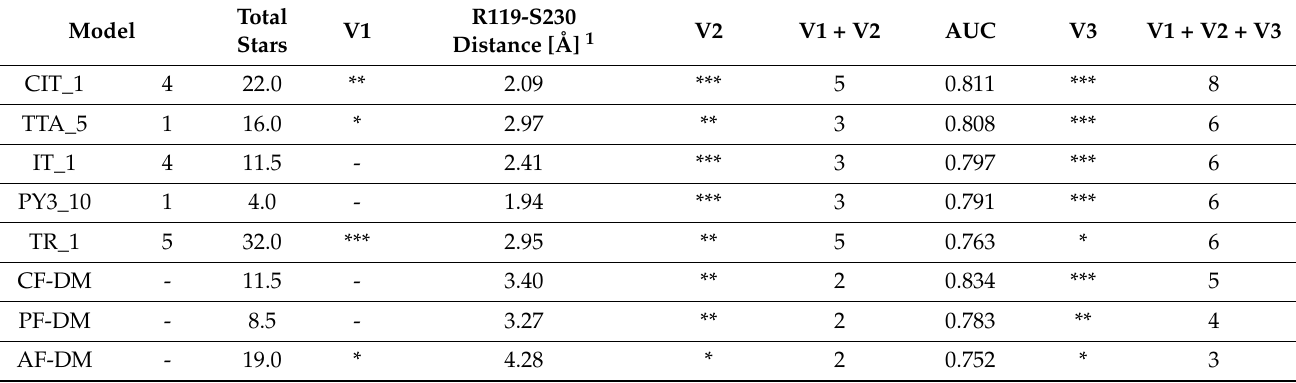
Table 2. Summary of stars ranking system of 8 models selected for further optimization: 5 models selected from preliminary ranking system (Materials and Methods, Section 4.5.1) and 3 DM models. Detailed description of V1–V3 values can be found in Materials and Methods, Section 4.5.2